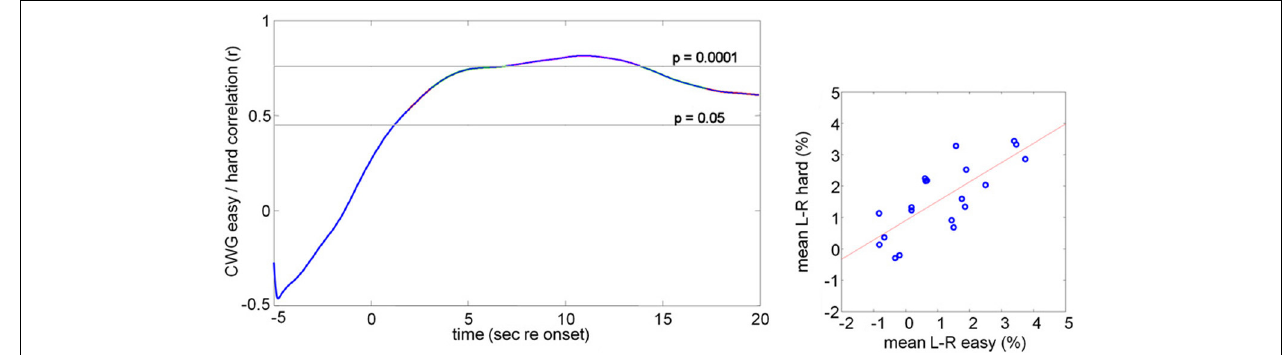
FIGURE 4 | Correlation of mean lateralization data. The right hand graph shows the mean CBFV difference within 2–15s after task onset for all participants. The data for the easy and hard conditions are highly correlated ( r = 0 . 76, n = 20, p = 0 . 0001). This analysis assumes constant lateralization patterns over the entire duration of the analysis window. An alternative